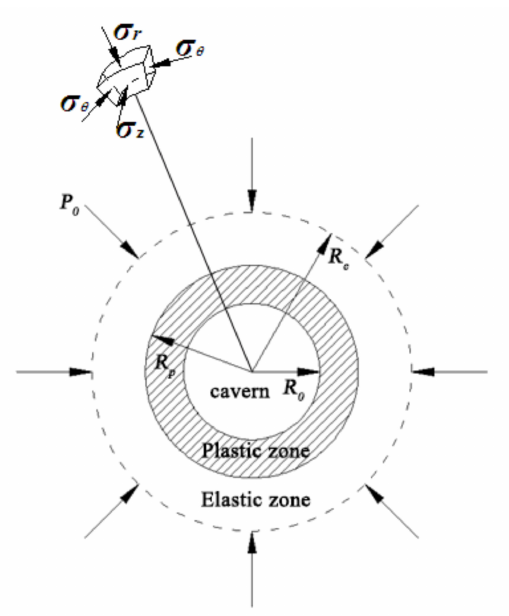
Figure 6. Mechanical state diagram of the surrounding rock of circular